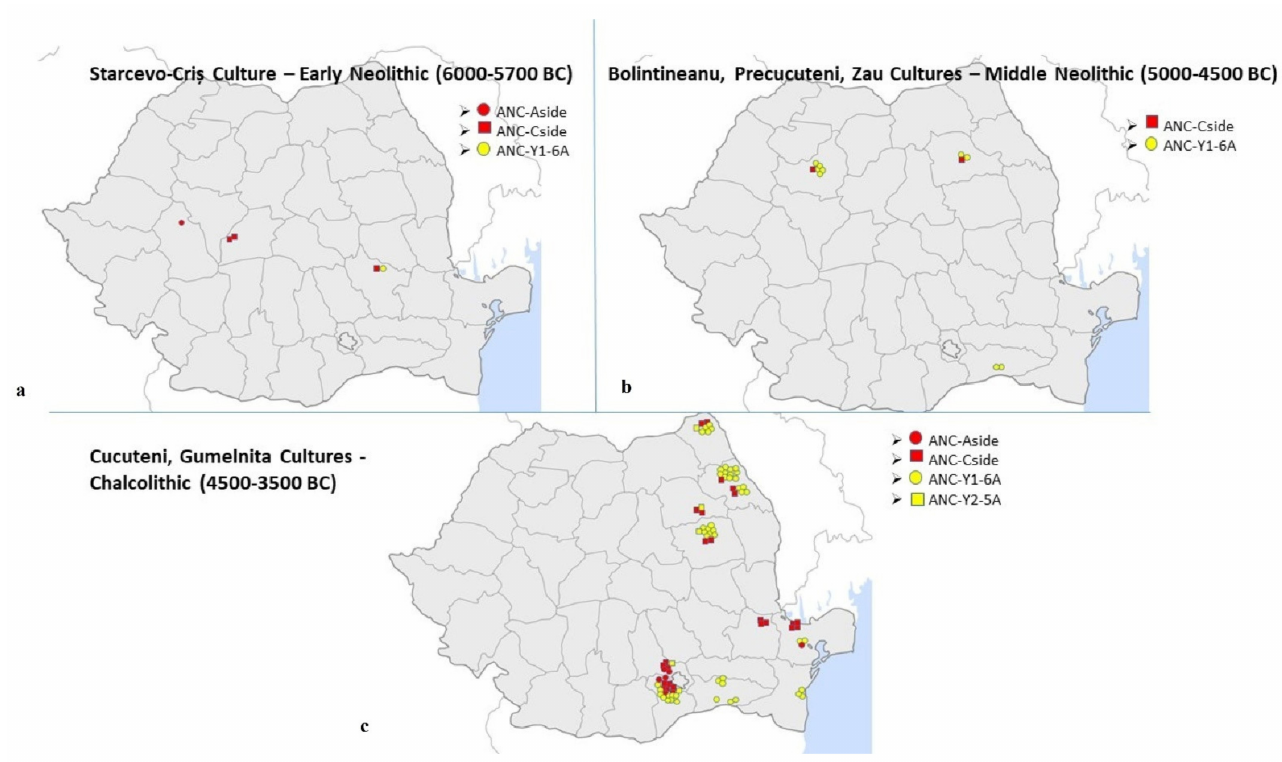
Figure 3. The spread of the Near-Eastern Sus scrofa genetic signature on Romanian territory during the Neolithic: ( a ). Haplotypes’ spread in the Early Neolithic; ( b ). Haplotypes’spread in the Middle Neolithic; ( c ). Haplotypes’ spread in the